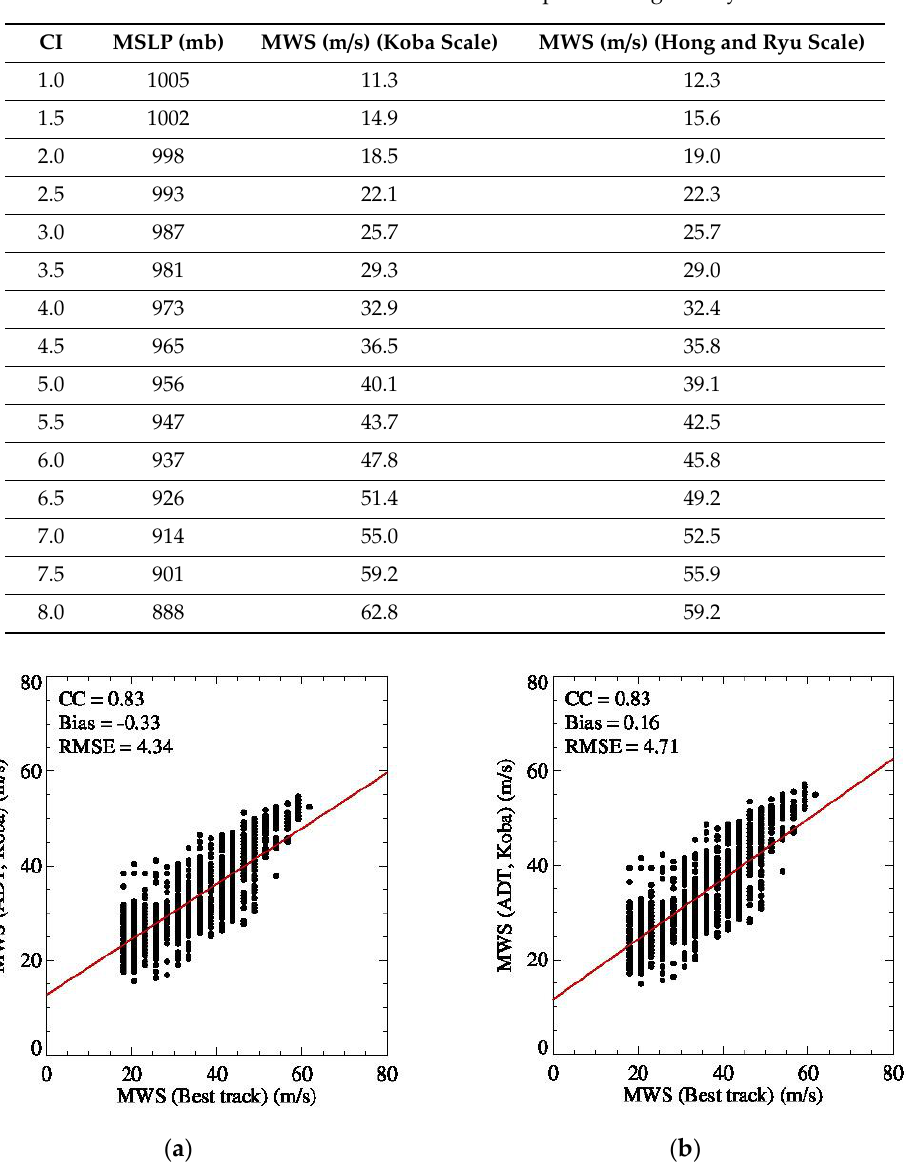
Figure 8. ( a ) MWS (best track) vs. MWS (Hong and Ryu scale) and ( b ) MWS (best track) vs. MWS